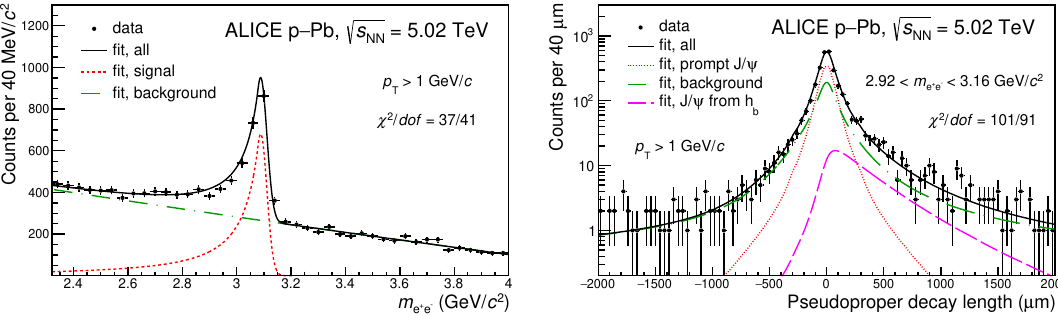
Figure 2 . Invariant mass (left panel) and pseudoproper decay length (right panel) distributions for J /ψ candidates with p > 1 GeV/ c . The latter distribution is limited to the J /ψ candidates under T the signal peak region 2 . 92 < m < 3 . 16 GeV/ c 2 . The projections of the maximum likelihood e + e − fit functions are shown superimposed and the χ 2 values of these projections are also reported for both